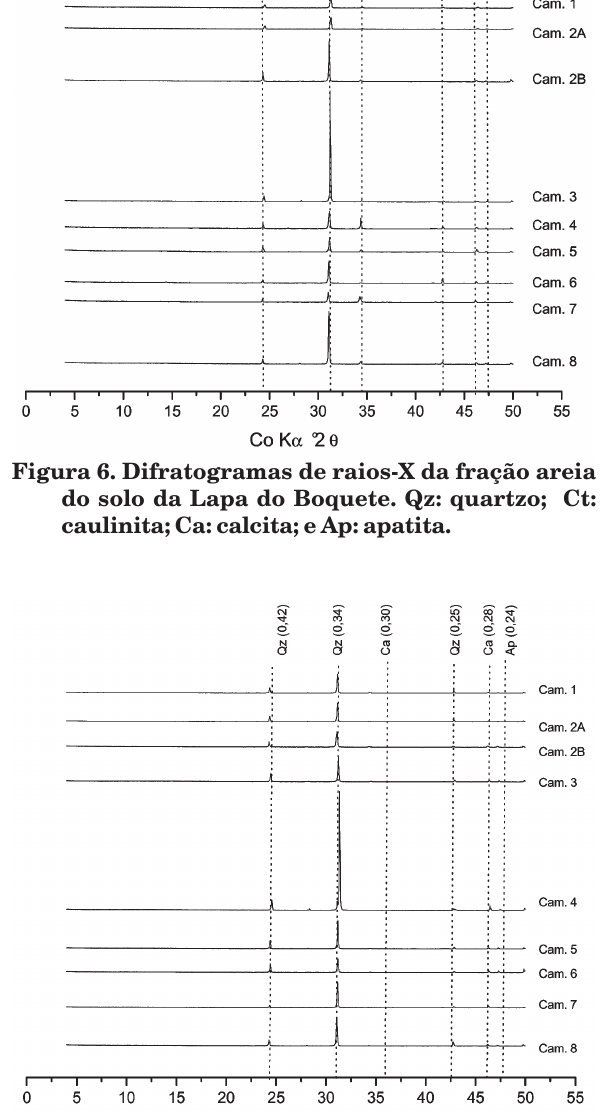
Figura 9. Difratogramas de raios-X da fração areia da camada 2B da Lapa do Malhador, após tratamento com solução de NaOH 5 mol L -1 . Mt: magnetita; Ca: calcita; Gt: goethita; Mn: manganita; e Ru: